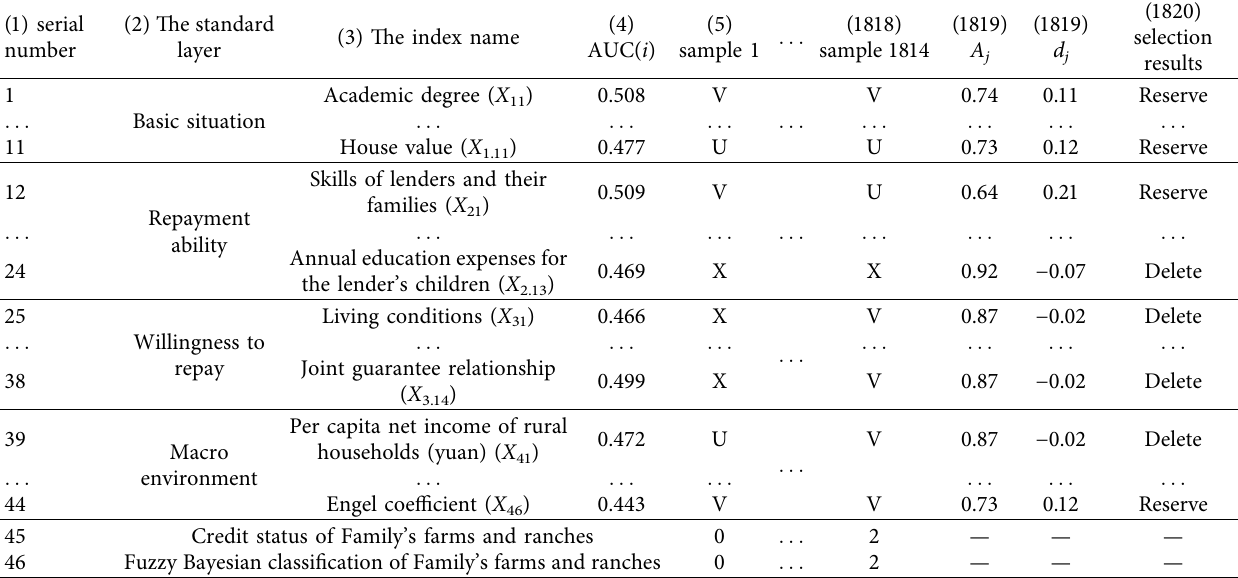
Figure 5. The blue curve in the figure represents the iden- tification results of high and low loss given default of 16 indexes finally screened out based on the depth-weighted fuzzy Bayesian model. The area under the blue curve AUC 0.586, AUC 0.5, which indicates that the depth- (cid:31) >